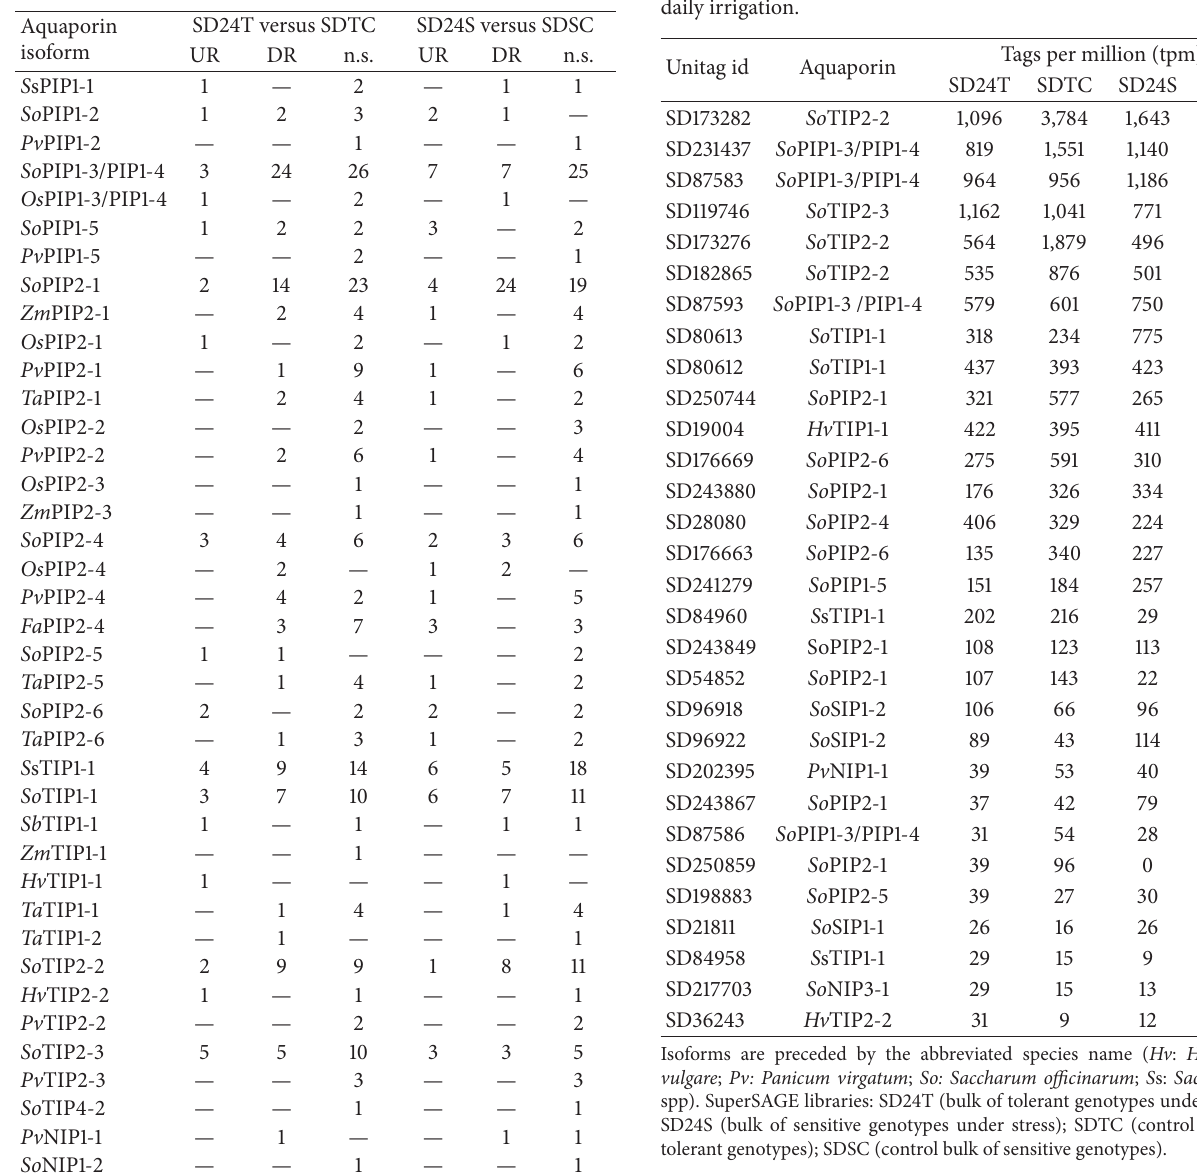
Table 2: Putative sugarcane aquaporin isoforms (42) based on unitags of root dehydration (24h) observed in the two main contrasts of HT-SuperSAGE libraries.